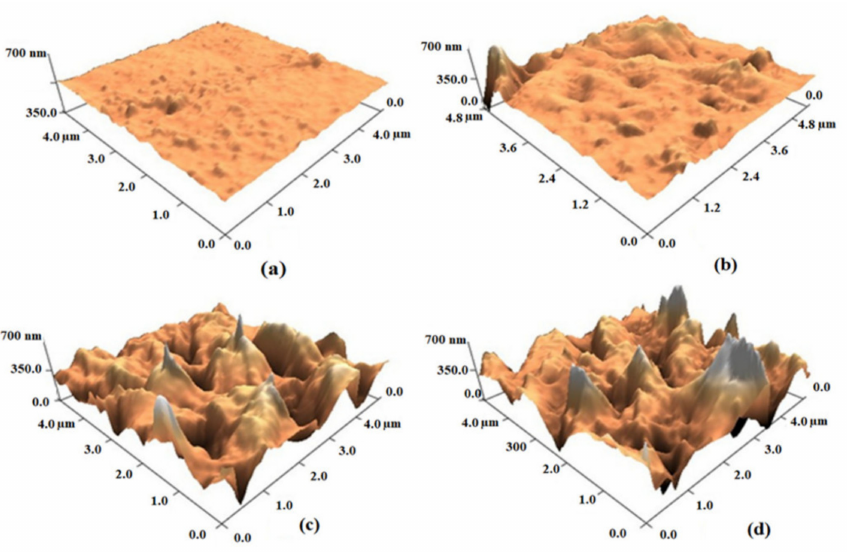
Figure 5. Atomic force microscopy (AFM) showing the measure of the roughness of ( a ) untreated zein-PLA film, ( b ) 60 kV, 5 min, ( c ) 70 kV, 5 min, ( d ) 80 kV, 5 min